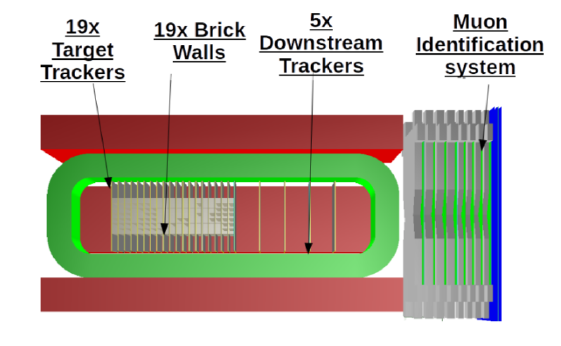
ciency with opening a longer gate around possible candi- dates in the hidden sector spectrometer.